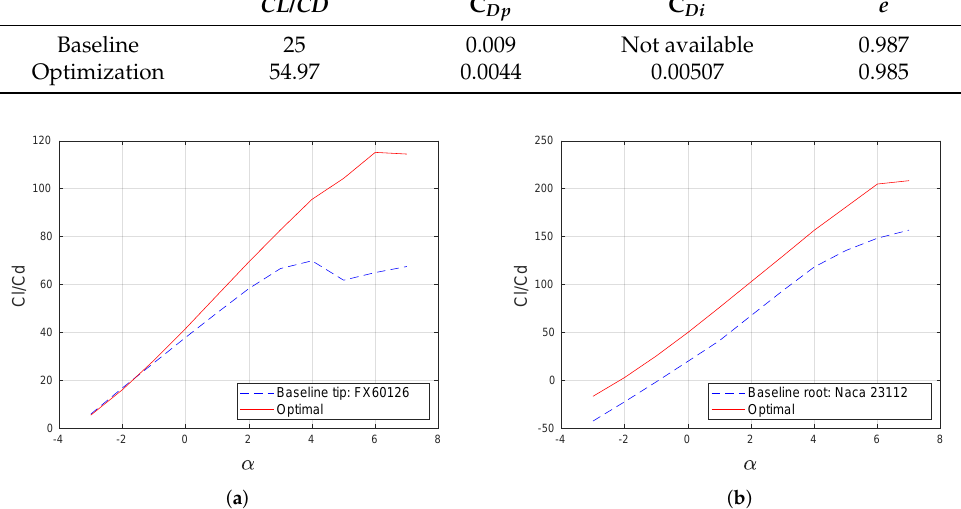
Figure 9. Lift-to-drag ratio comparison between baseline and optimized tip ( a ) and root airfoils ( b